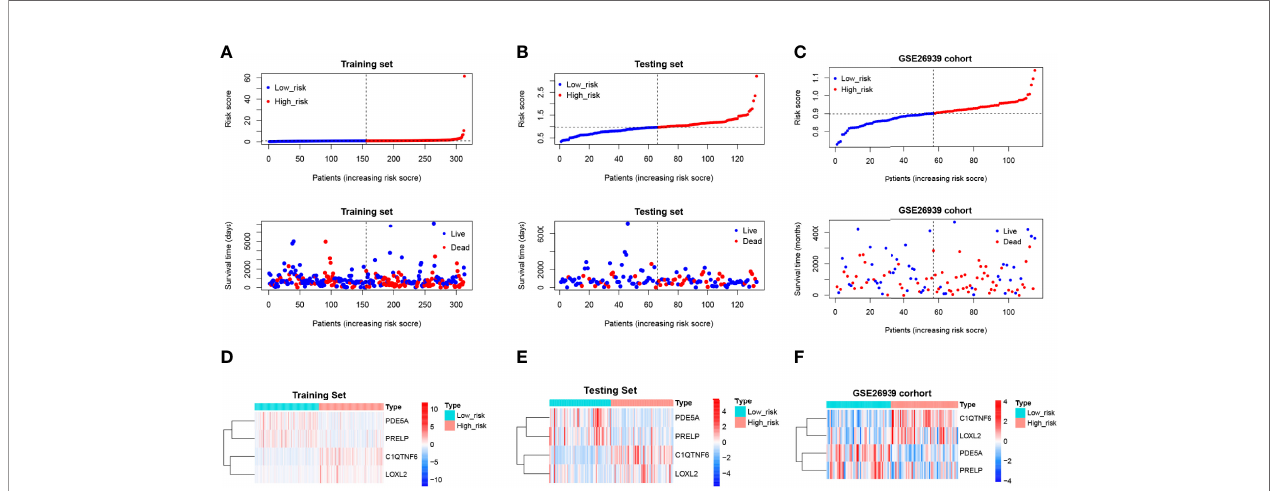
FIGURE 7 | Risk pro fi le of the risk model and heat map of gene expression in the high-risk and low-risk groups. (A – C) Training, test, and validation set risk curves. Scatter plots were derived from survival times and risk scores. With increasing risk scores, the number of patients who died increased, and the survival gradually shrank. (D – F) Training, test, and validation set model gene expression heat maps. The horizontal axis represents the sample, while the horizontal axis represents the risk score and the survival of the sample. The vertical reference line represents the sample position corresponding to the median risk score, with low-risk patients on the left and high-risk patients on the right. According to the heat map results of the training, test, and veri fi cation sets, PDE5A and PRELP were poorly expressed in the high-risk group, while C1QTNF6 and Loxl2 were highly expressed in the high-risk